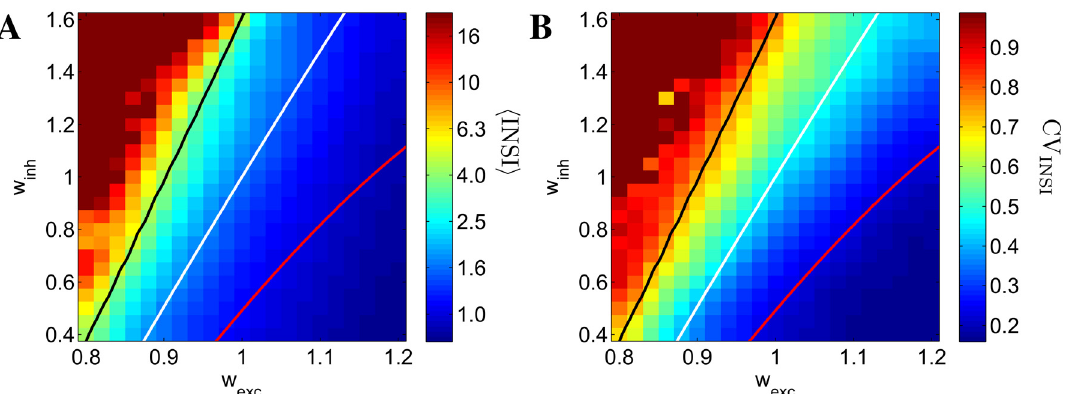
Fig 2. Inter-network-spike interval (INSI) statistics in the noisy mean-field model, for varying levels of excitation (w exc ) and inhibition (w inh ). Panel A: h INSI i (the scale is in seconds); panel B: coefficient of variation of INSI (CV INSI ). For high net excitation (bottom-right quadrant) short-term depression plays a determinant role in generating frequent and regular (low CV INSI ) NSs; for weak excitability (upper-left quadrant) random fluctuations are essential for the generation of rare, quasi-Poissonian NSs (CV INSI ’ 1). The solid lines are isolines of the real part < λ of the dominant eigenvalue of the mean-field dynamics ’ Jacobian; white line: < λ = 0 Hz; red line: < λ = 3.5 Hz; black line: < λ = − 3.5 Hz. Note how such lines roughly follow isolines of h INSI i and CV INSI .